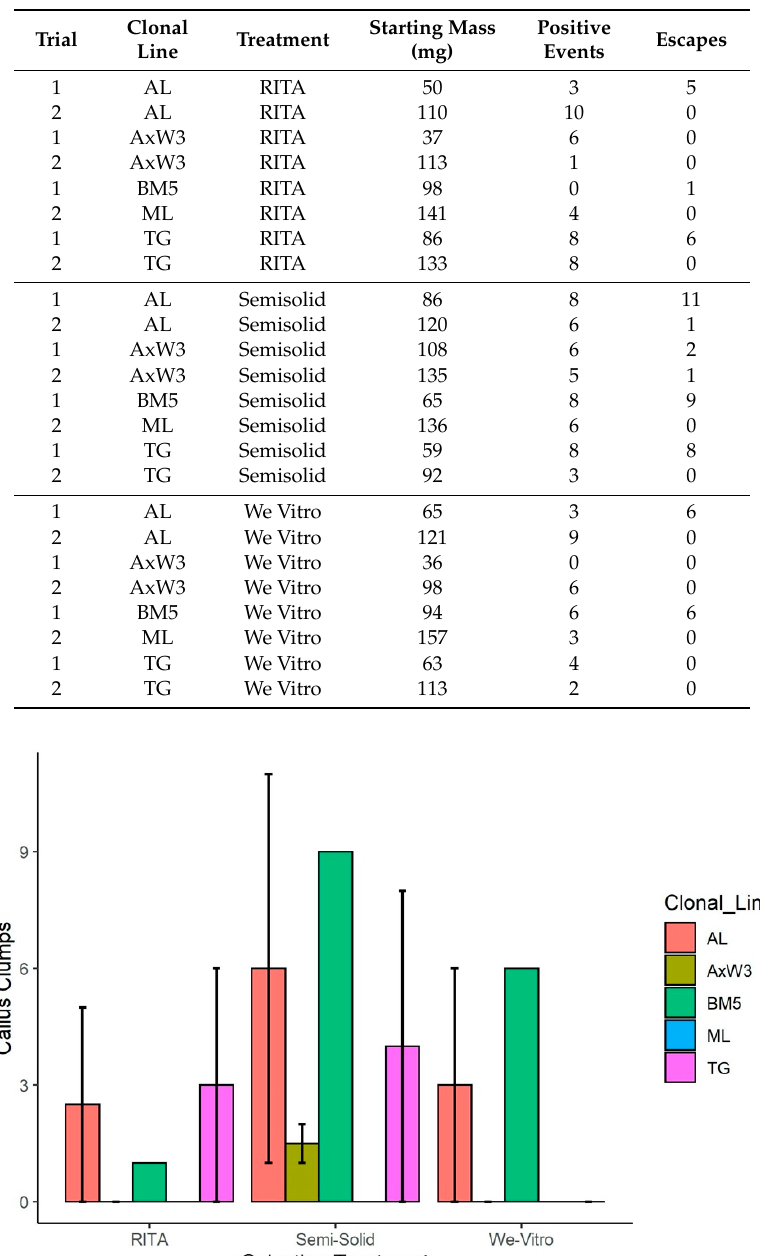
Table 1. Number of positive events and escapes per starting mass in transformation using p35S-OxO. American chestnut clonal lines were Alessi T2-1A (AL), AxW3-46B (AxW3), Bass Mountain #5-1B